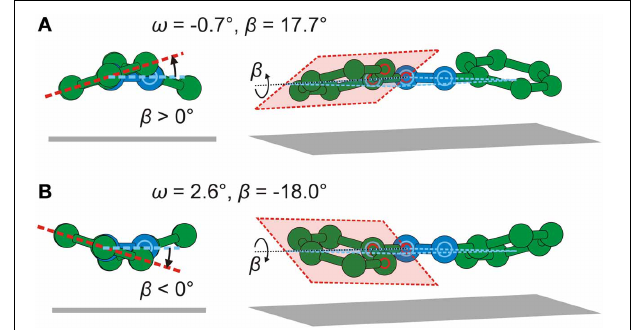
FIGURE 11 | Two possible adsorption geometries of AB/Ag(111) resulting from Fourier vector analysis. (A) Side view and perspective view of AB with ω = − 0 . 7 ◦ and β = 17 . 7 ◦ . (B) Side view and perspective view of AB with ω = 2 . 6 ◦ and β = − 18 . 0 ◦ . The planes containing atoms C,C,N are marked in red and the corresponding atoms are indicated by red circles. The planes containing atoms C,N,N are marked in light blue and the corresponding atoms are indicated by light blue circles. C atoms: green spheres. N atoms: blue spheres. For clarity, H atoms are not